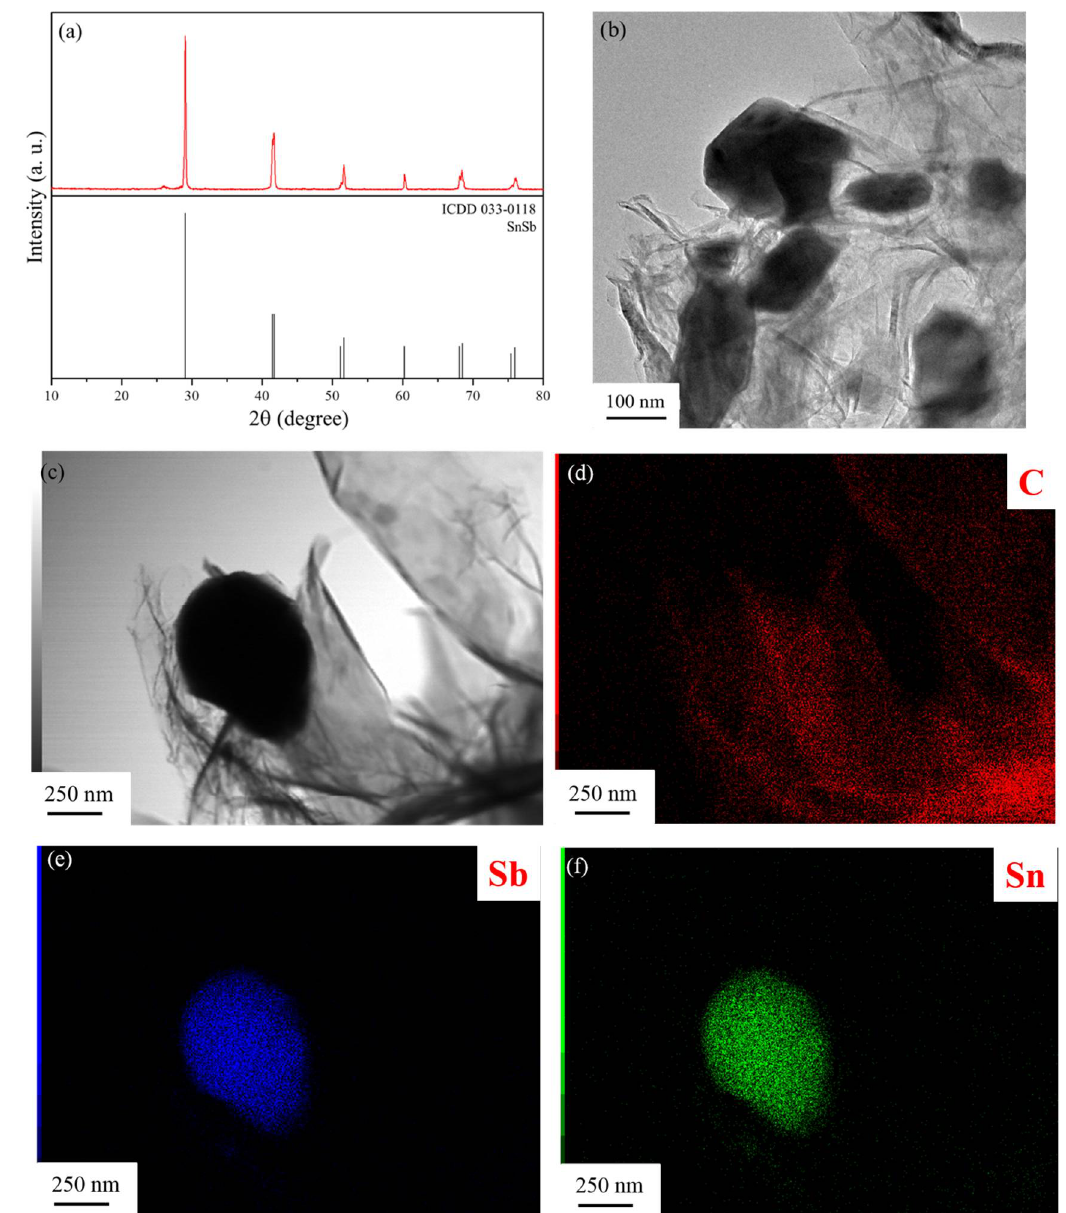
Fig ure 1. ( a ) XRD patterns of SnSb/RGO+C. ( b ) TEM image of SnSb/RGO. ( c ) SnSb single particle used for EDS mapping. ( d ) Distribution of graphene (carbon). ( e ) Distribution Sb. ( f ) Distribution Sn.